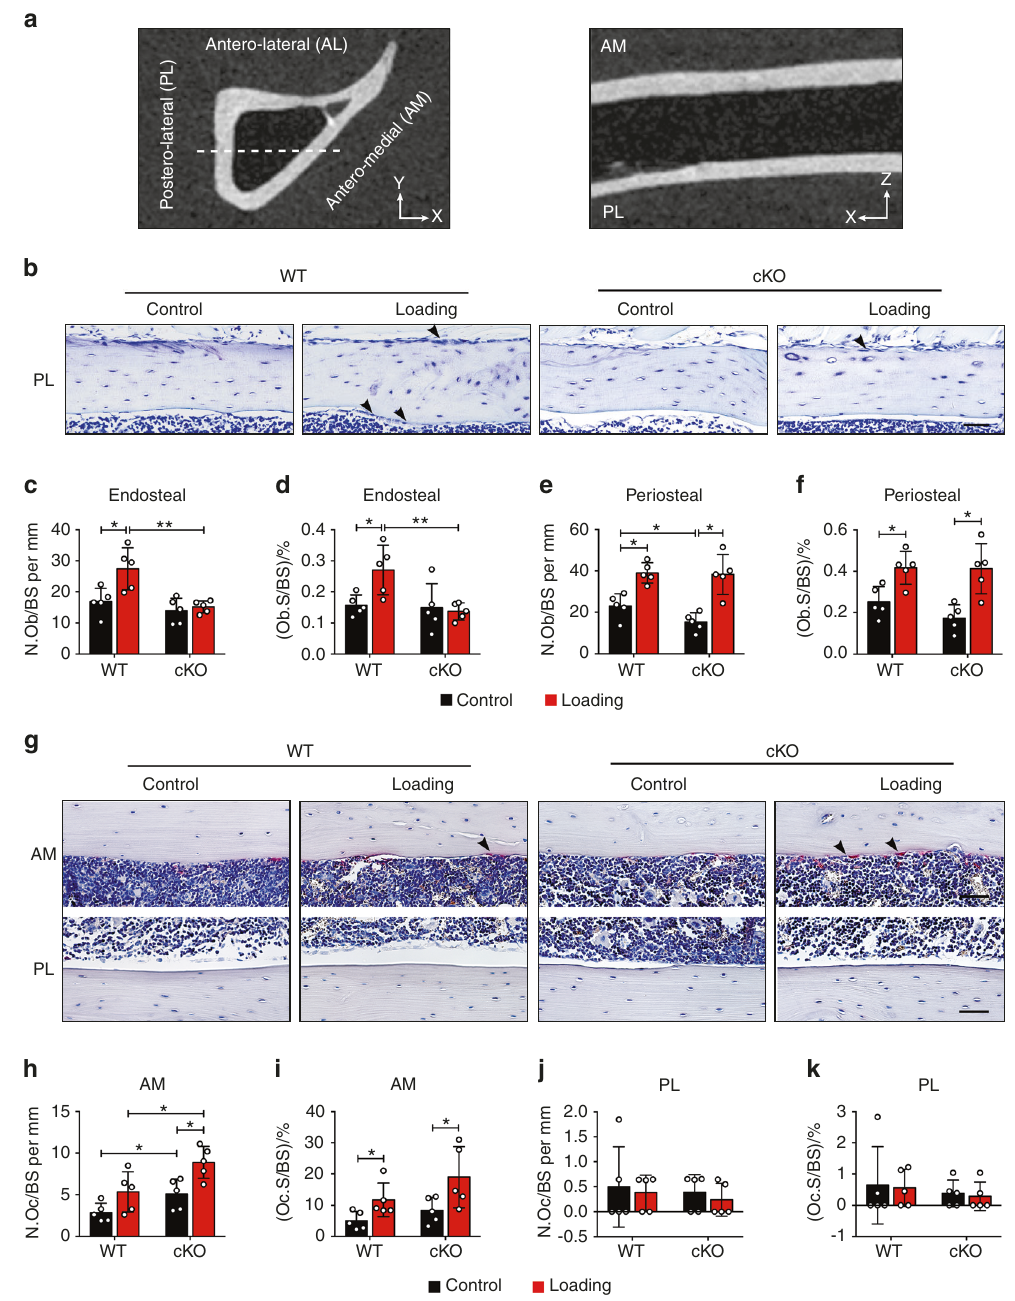
Fig. 5 Integrin α 5 in osteocytes inhibited loading-induced increase in osteoblast activity. a Gray-scale μ CT images of transverse, sagittal sections. The dotted lines showed the locations of sagittal paraf fi n sections on transverse cross-section of the tibia bone (left panel) and the sagittal image showed the paraf fi n sections obtained (right panel). b Representative toluidine blue staining showed the osteoblasts on postero-lateral (PL) periosteal and endosteal surfaces of 37% diaphysis, for both loaded and contralateral, unloaded tibias of WT and cKO mice. The representative osteoblasts are indicated (black arrows). Scale bar: 50 μ m. Quanti fi cation of osteoblast number per bone perimeter (N.Ob/ BS) ( c , e ) and osteoblast surface per bone perimeter (Ob.S/BS) ( d , f ) on PL endosteal ( c , d ) and periosteal ( e , f ) surfaces of 37% diaphysis. n = 5 per group. g Representative images of TRAP-positive osteoclasts (black arrow) on antero-medial (AM) and PL endosteal surfaces of 37% diaphysis, for both loaded and contralateral, unloaded tibias of WT and cKO mice. Scale bar: 50 μ m. Quanti fi cation of TRAP-positive osteoclast number per bone perimeter (N.Oc/BS) and osteoclast surface per bone perimeter (Oc.S/BS) on AM ( h , i ) and PL ( j , k ) endosteal surfaces of 37% diaphysis. n = 5 per group. Mean ± SD. * P < 0.05; ** P < 0.01 . Paired t test was done for loaded and contralateral tibias and unpaired t test was done for loaded or control tibias between WT and cKO mice increase in bone formation and osteoblast activity on the tibial We determined the role of osteocytic integrin α 5 using an axial postero-lateral endosteal surface in WT mice. Postero-lateral tibial compression model. Our results demonstrated differential endosteal surface is the region where the peak strain occurs, responses to mechanical loading occurring on the periosteal and which is 1.5 to 2 times higher than those on the antero-medial endosteal bone surfaces. Mechanical loading showed a signi fi cant Bone Research (2022)